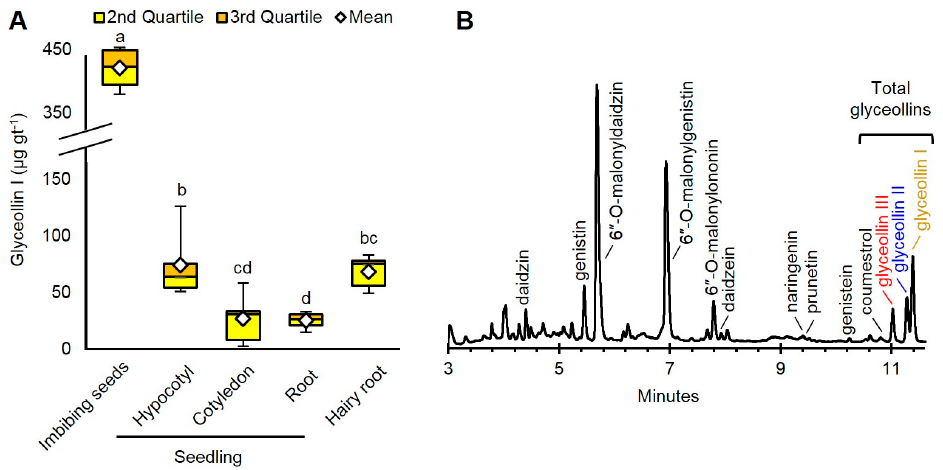
Figure 2. ( A ) Amounts of glyceollin I from soybean organs treated with wall glucan elicitor (WGE) from Phytophthora sojae . Two-way ANOVA, Tukey post hoc test ( p < 0.001); ( B ) UPLC-PDA chromatogram at 283 nm of isoflavonoids from imbibing seeds. Isoflavonoid identities were determined by UPLC-PDA-MS n retention time, fragmentation pattern, and absorbance features by comparison to standards (commercial or purified) and by comparison to the literature (Supplementary Table S1). Different letters show significant differences by ANOVA